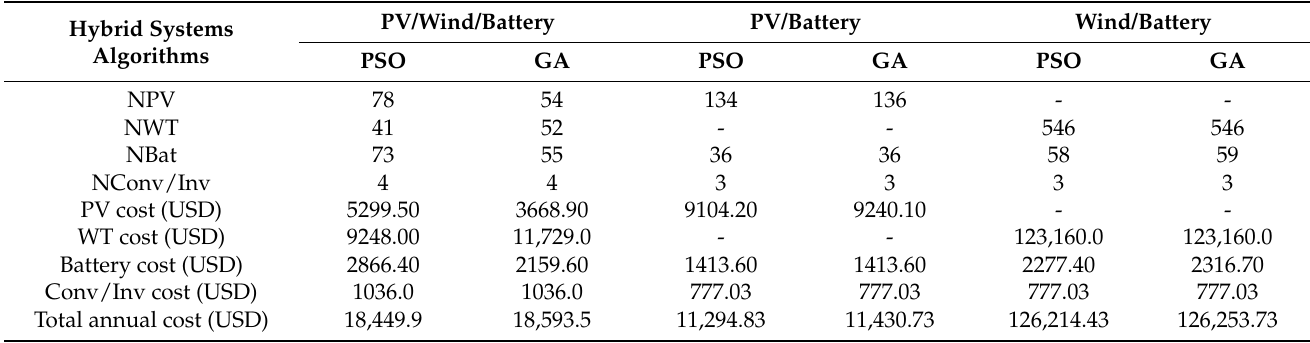
Table 5. Results of optimal sizing for